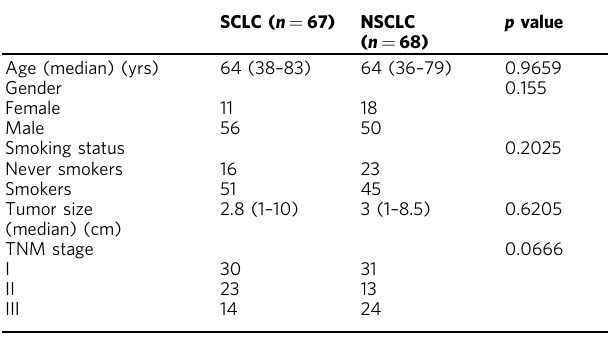
Table 1 Clinical characteristic comparison of SCLC and NSCLC